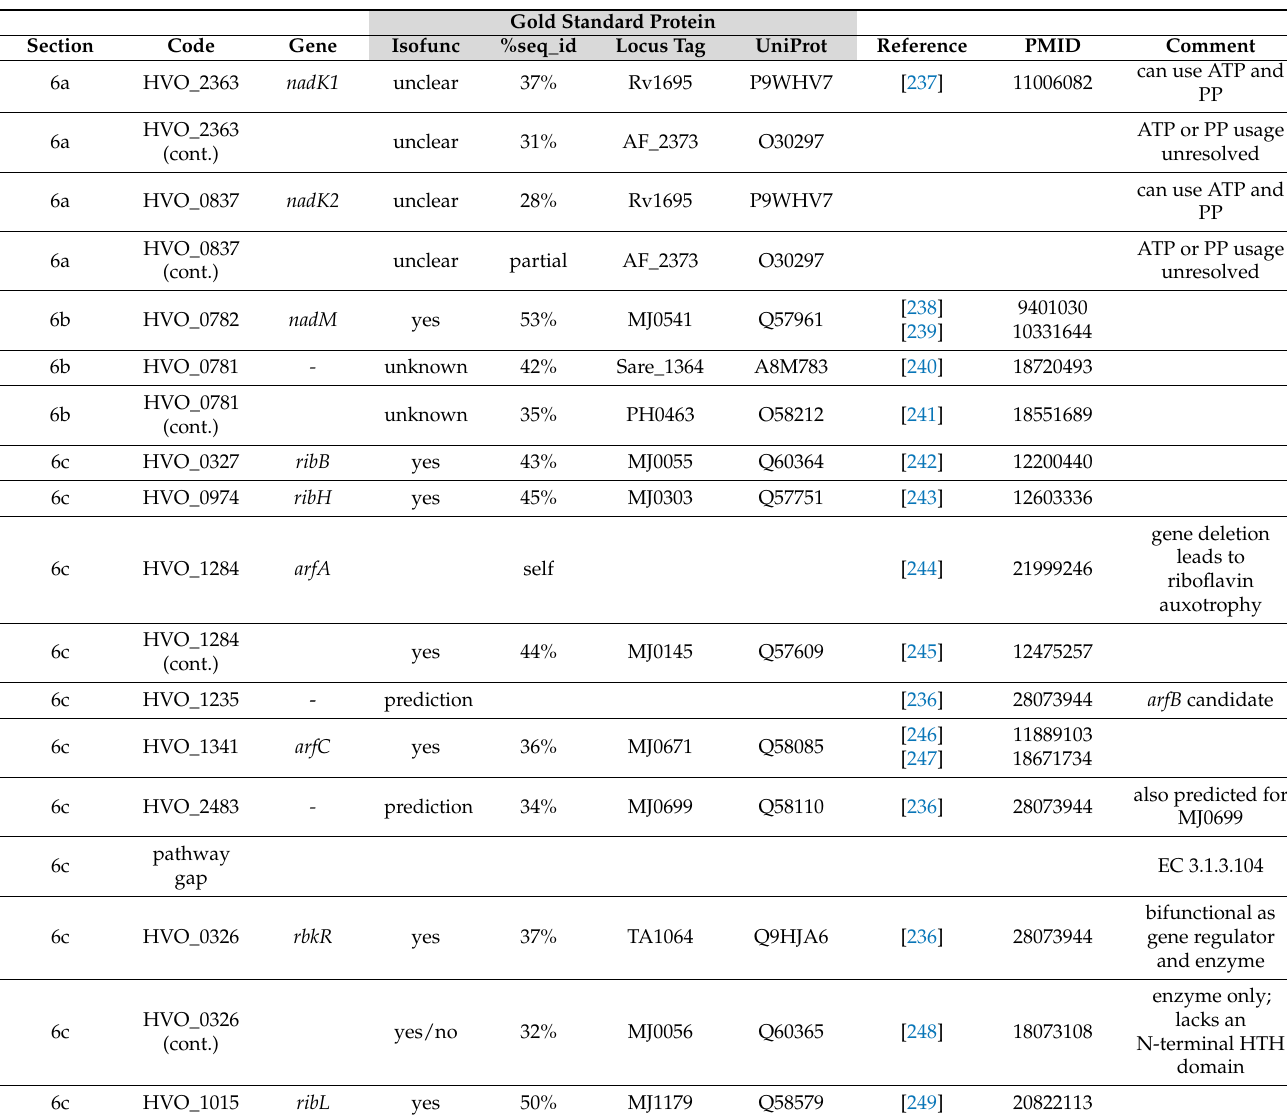
Table 6. Three pathway gaps remain, with candidate genes predicted for two of these [236] (for details, see Supplementary Text S1 Section S6). Table 6. Proteins with open annotation issues and their Gold Standard Protein homologs (Section 3.6). For a description of this table, see the legend to Table